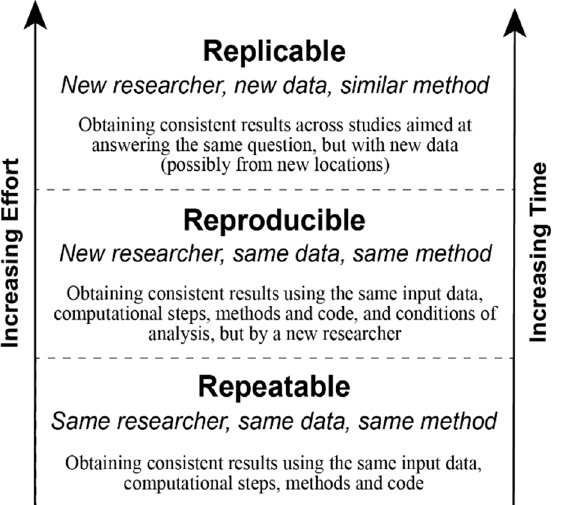
Figure 1. Typology of R&R concepts showing progression of effort and time. Adapted from Essawy et al. [24].